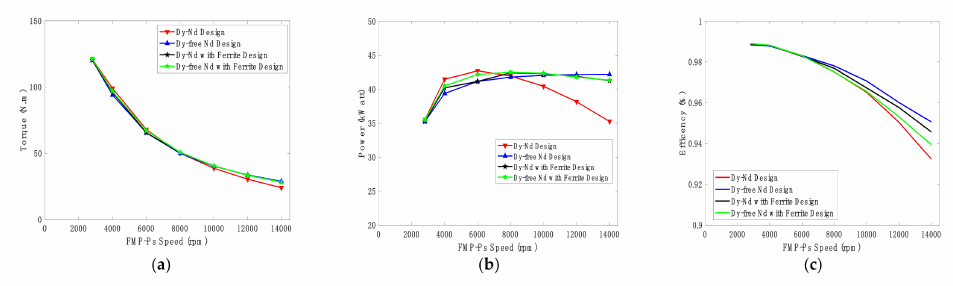
Figure 14. ( a ) Torque-speed curve, ( b ) power-speed curve, and ( c ) efficiency-speed